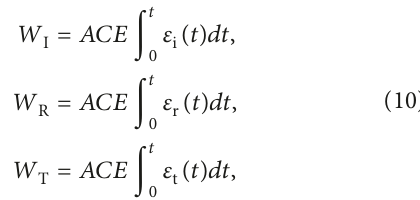
Figure 9: Fractal dimension at mass-equivalent dimension.